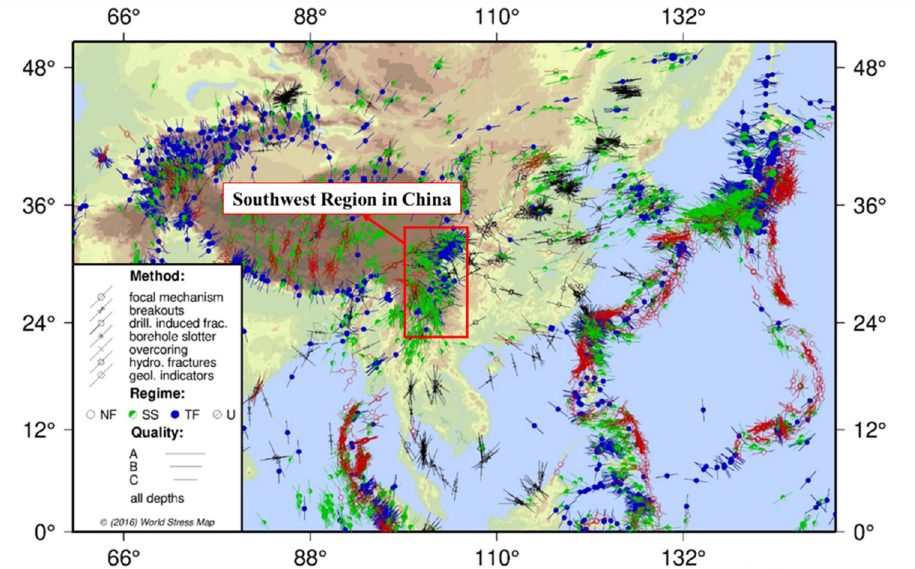
Figure 3. Stress distribution map of China [50,51].